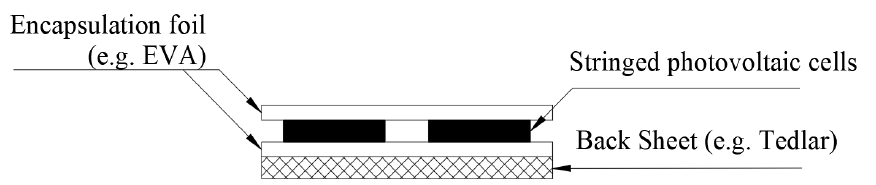
Figure 4. Structure of PV layer.